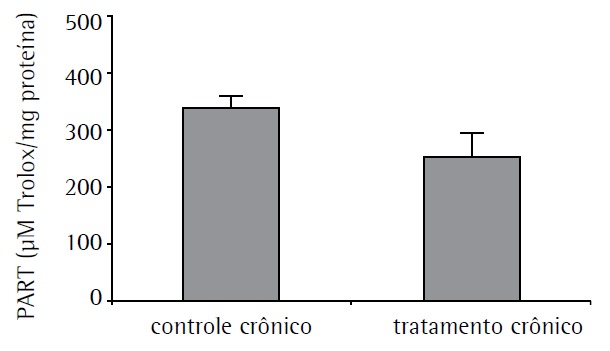
 Média dos níveis de potencial antioxidante reativo total (PART) nos
pulmões de ratos submetidos a administração crônica de metilprednisolona
oral (grupo de tratamento crônico) ou não (grupo de controle crônico).
Trolox: ácido 2-carboxílico-6-hidroxi-2,5,7,8-tetrametilcromano.